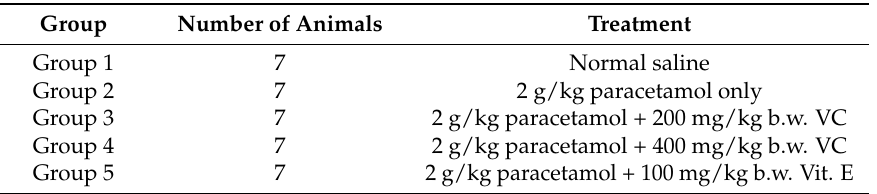
Table 1. Experimental treatment